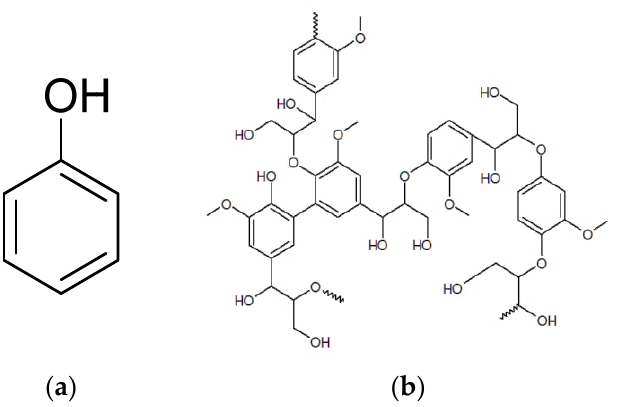
Figure 1. Structure of the main components of the wood leachate (WL) ( a ) phenol, and ( b ) lignin.